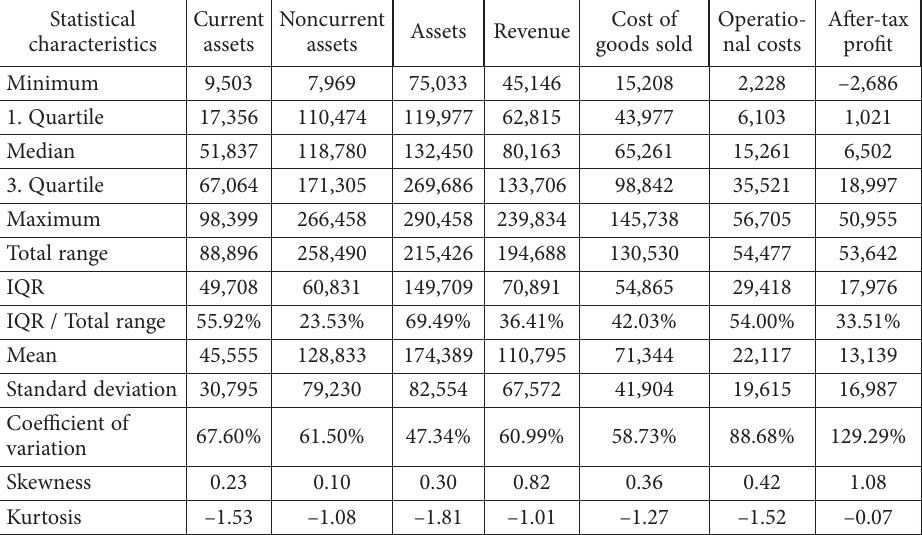
Table 4. Descriptive statistics of Big companies (source: own calculation by R Studio (average of 4 years)) (million tugriks) Statistical